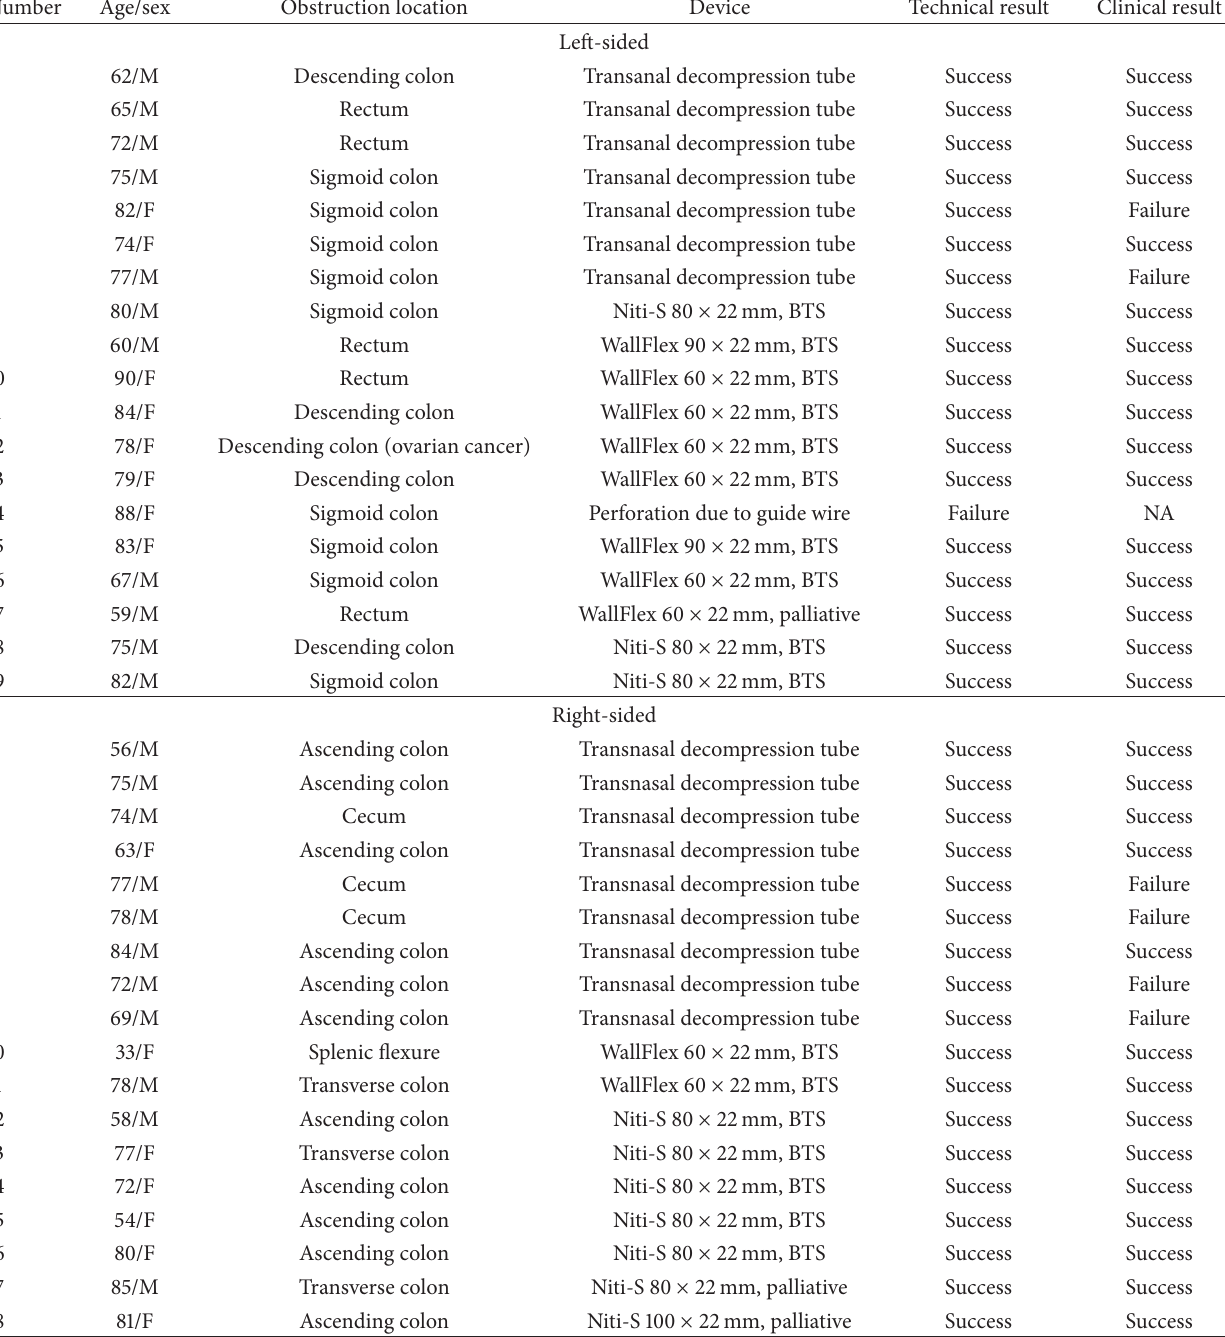
Table 1: Patient demographics and procedure details of this